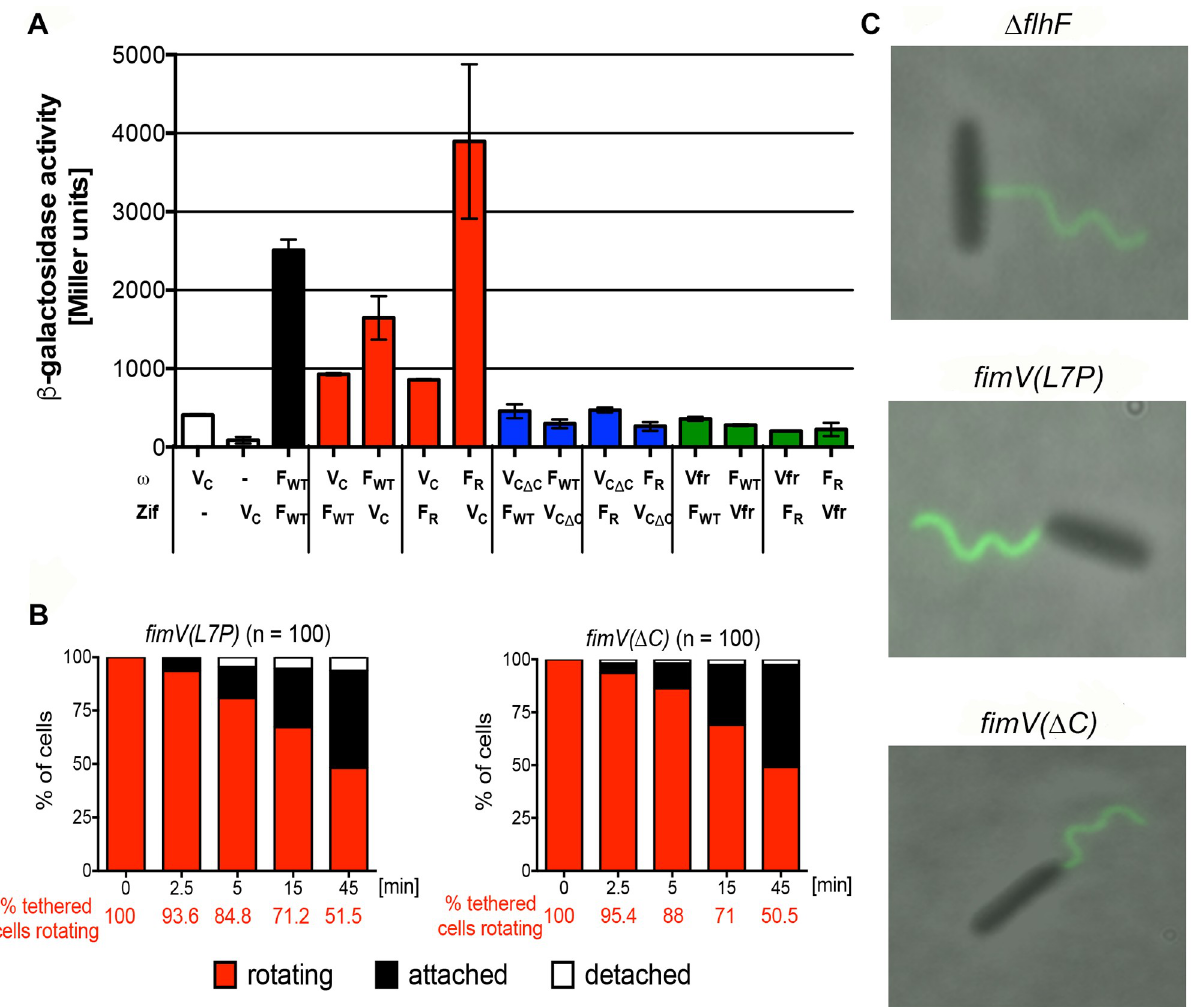
Fig 4. The carboxy terminus of FimV mediates interactions with FlhF and is required to stop rotation of tethered bacteria. (A) FlhF interacts with the carboxy terminus of FimV . FlhF interactions with FimV and Vfr were assayed by bacterial two-hybrid. ω or Zif fusions were constructed as indicated, with interactions resulting in beta-galactosidase expression and activity (reported in Miller units). Bars show mean ± S.D. (n = 3) for a representative experiment. FlhF (F WT ), which forms a homodimer, served as a positive control (black bar). FimV (V C ) interacted with both wild-type (F WT ) and R251G alleles (F R ) of FlhF (red bars), but gave no signal when co-expressed with either the ω or Zif domain alone (white bars). Neither allele of FlhF interacted with a FimV construct lacking the final 150 aa (V C Δ C , blue bars) nor with Vfr (green bars). (B) Surface-tethered bacteria